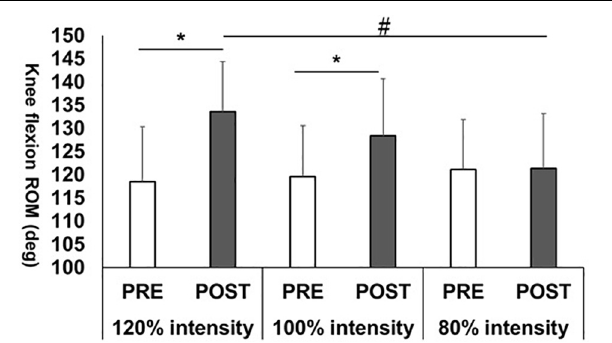
FIGURE 1 | Knee flexion range of motion (ROM) changes before (PRE) and after (POST) stretching intervention.* p < 0.01, significant difference between PRE and POST; # p < 0.01, significant difference between 120 and 80%